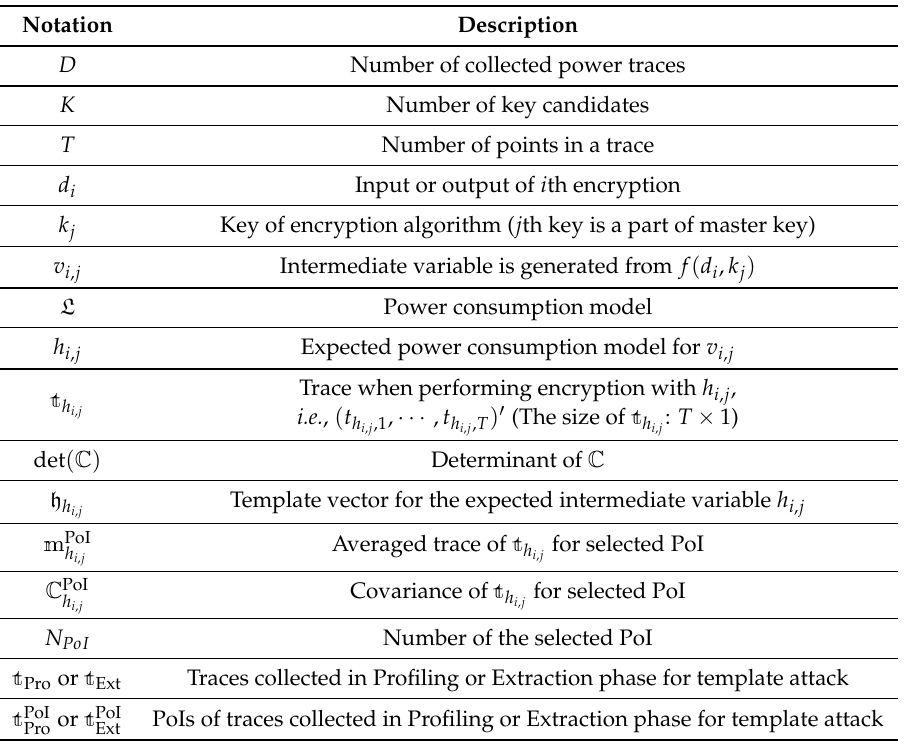
Table 1. Notations for template